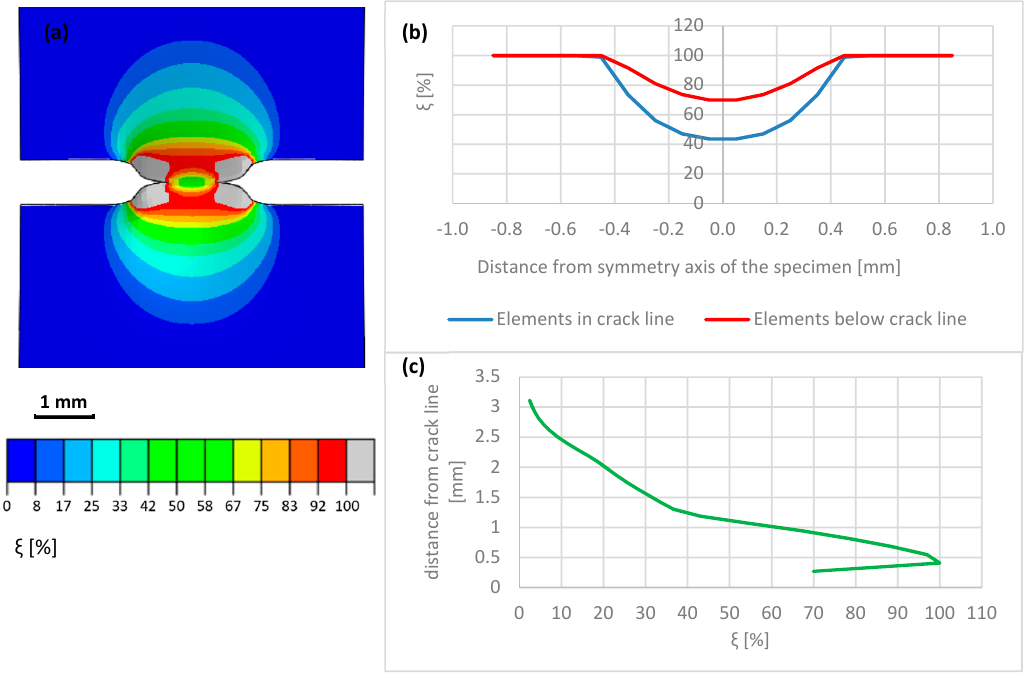
Figure 17. Intermediate stage (II) of double crack propagation: ( a ) map of volume fraction of martensite ( b ) tip-to-tip distribution of the secondary phase ( c ) ξ -profile along the axis of the sample (perpendicular to the tip-to-tip axis).